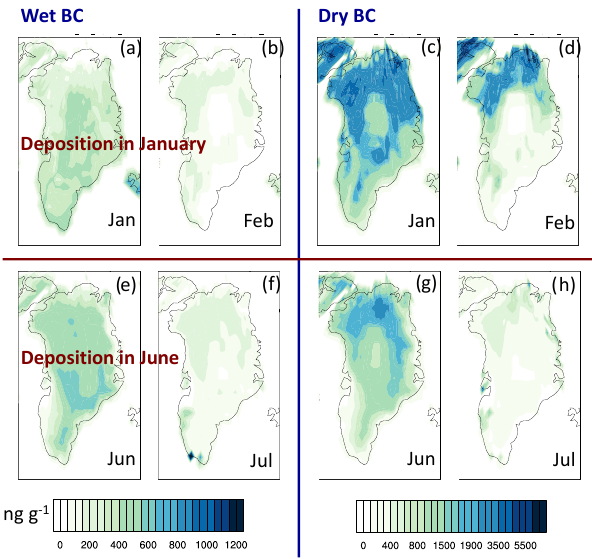
Figure 2. The 10-year (2006–2015) averaged hydrophilic BC con- centration associated with wet deposition (a, b, e, f) and hydropho- bic BC concentration associated with dry deposition (c, d, g, h) in the top snow layer. The contour maps show concentrations caused by January deposition (a–d) and June deposition (e–h) , associated with the maximum wet and dry deposition scenarios depicted in Fig. 1.